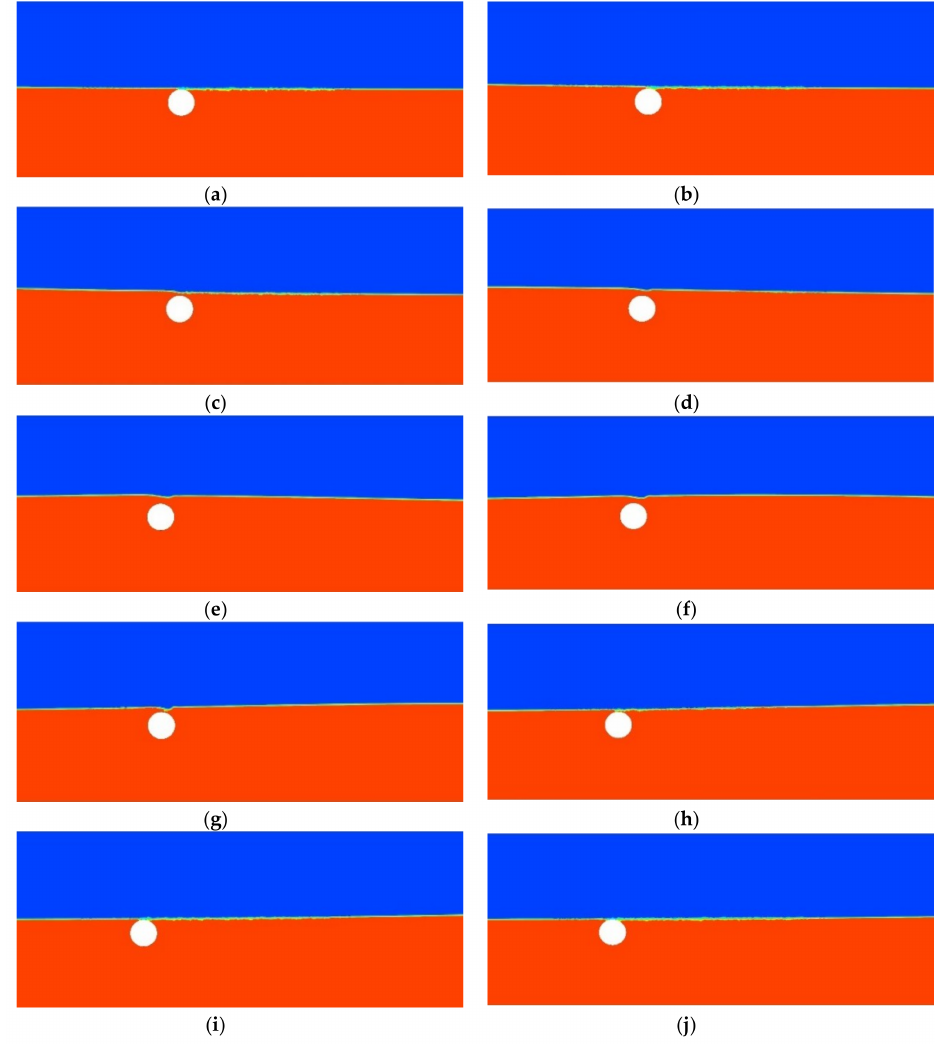
Figure 27. Snapshot of evolution process of a solitary wave interacting with the moving cylinder U c = 0.1 m / s for model 4. ( a ) t = 16.5 s, ( b ) t = 17 s, ( c ) t = 17.5 s, ( d ) t = 18 s, ( e ) t = 18.5 s, ( f ) t = 19 s, ( g ) t = 19.5 s, ( h ) t = 20 s, ( i ) t = 20.5 s, ( j ) t = 21